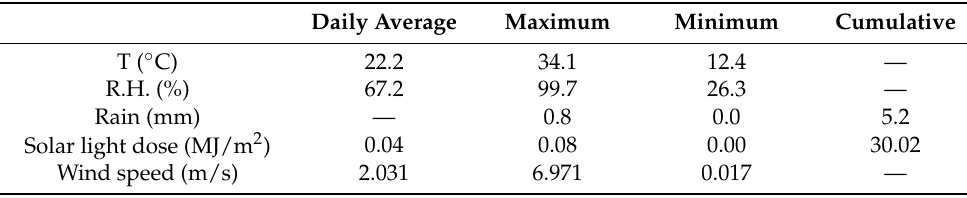
Table 2. Meteoclimatic data during the period of outdoor